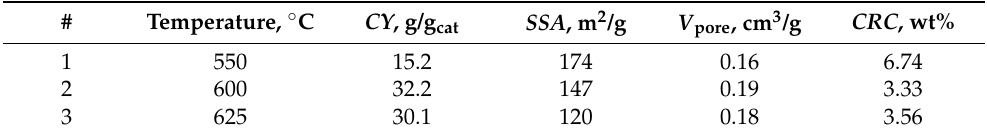
Figure 9. TEM images of the carbon nanofibers obtained via the decomposition of methane–hydrogen mixture at 625 ◦ C. The magnification is ( a ) 25,000 × ; ( b ) 50,000 × ; ( c ) 600,000 × . Table 1. Textural characteristics (specific surface area, SSA , and pore volume, V pore ) and the content of residual catalyst ( CRC ) for CNF samples obtained via decomposition of CH 4 /H 2 mixture over NiO-CuO/Al 2 O 3 catalyst at 550, 600 and 625 ◦ C.